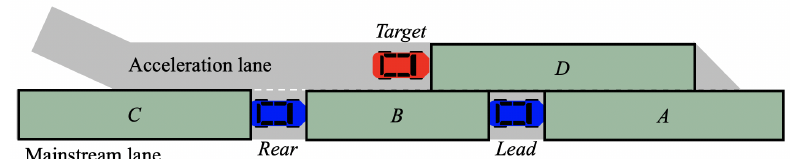
Figure 2. Problem definition: the lane-changing vehicle is defined as the target, and it is represented in red. The preceding vehicle on the mainstream lane is defined as the lead, and the following vehicle on the mainstream is defined as the rear. The two vehicles are indicated in blue. There are four classes as goals for the target vehicle. The A class indicates the front space of the lead vehicle, the B class is the space between the lead and rear vehicles. Furthermore, the C class represents the behind space of the rear vehicle. Lastly, the D class indicates that the target maintains the current